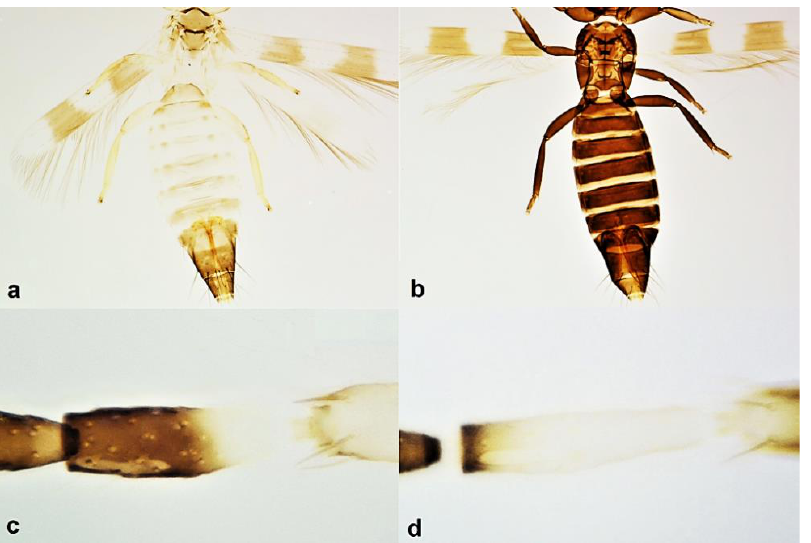
Figure 8. Body ( a , b ): ( a ) bicoloured; ( b ) uniformly brown; antennal segment III ( c , d ): ( c ) distal half brown; ( d ) only distal fifth brown. Antennal segment III with sensorium being one third the length of the segment (Figure 9a); antennal segment IV with sensorium two thirds the length of the segment (Figure 9a); pronotum pale, often yellow (Figure 9c) …….. Aeolothrips melisi Priesner Antennal segment III and IV with sensoria about half the length of the segment (Figure 9b); pronotum dark, usually brown (Figure 9d) ………………………………… ........................................................................................... Aeolothrips tenuicornis Bagnall